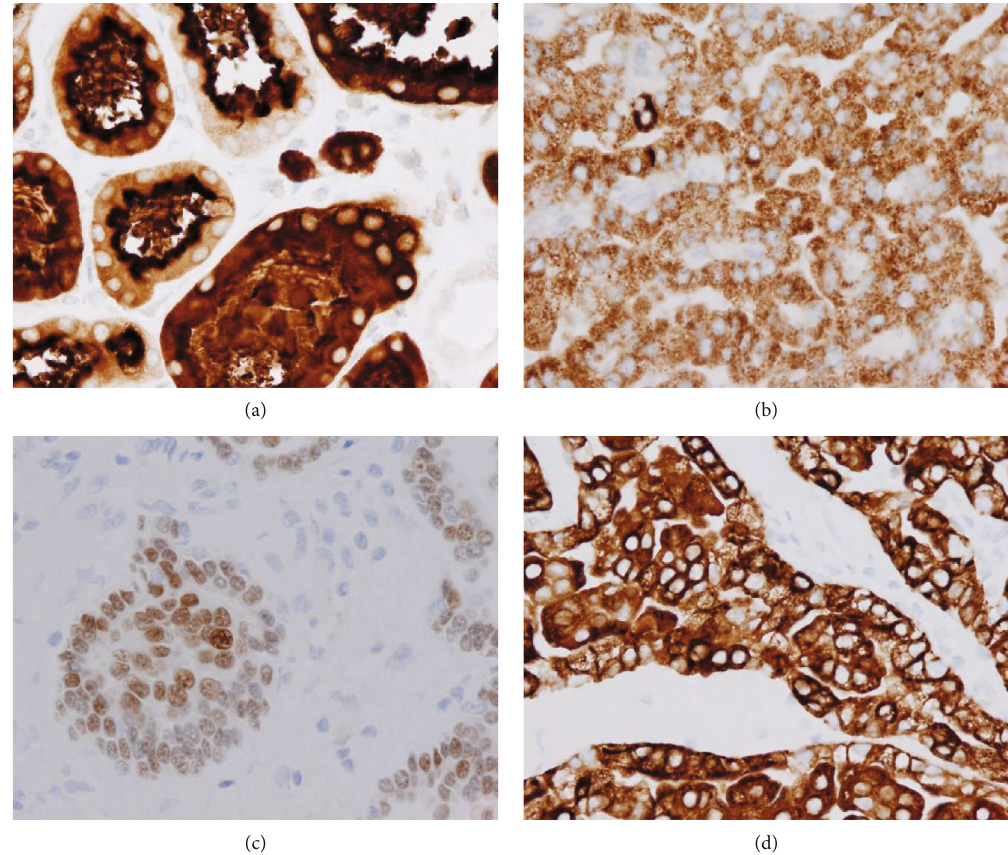
Figure 3: P-RCC immunohistochemistry: (a) CD10, (b) AMACR, and (c) PAX-8 are routinely positive in type II papillary renal cell carcinoma. (d) CK7 displays reactivity in the majority of type 1 papillary renal cell carcinoma, but is found in 20% of type 2 tumors as well (400x magni fi